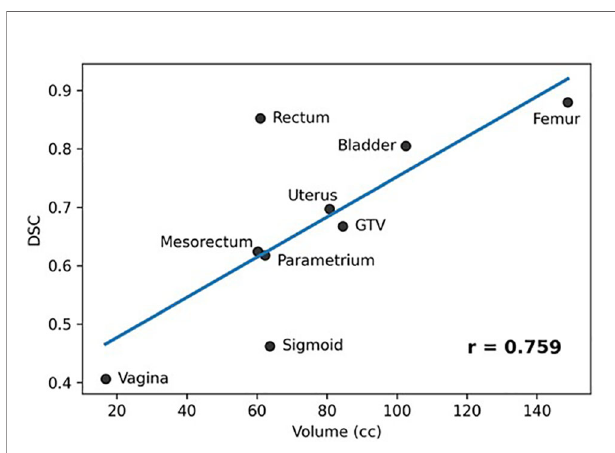
FIGURE 4 | Association between averages of manual stmctures' volumes and corresponding DCS (Pearson Coef fi cient = 0.759, p